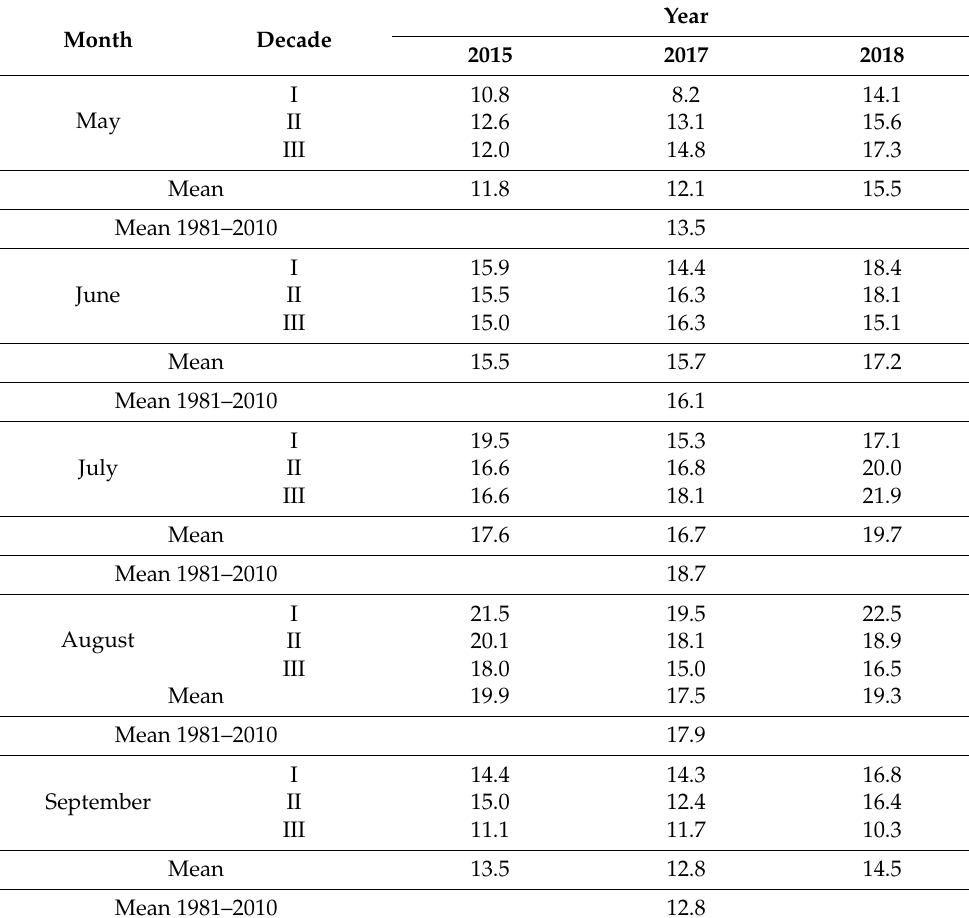
Table 4. Mean ten-day and monthly air temperatures during the study according to the Hydrological and Meteorological Station in Tomaszkowo ( ◦